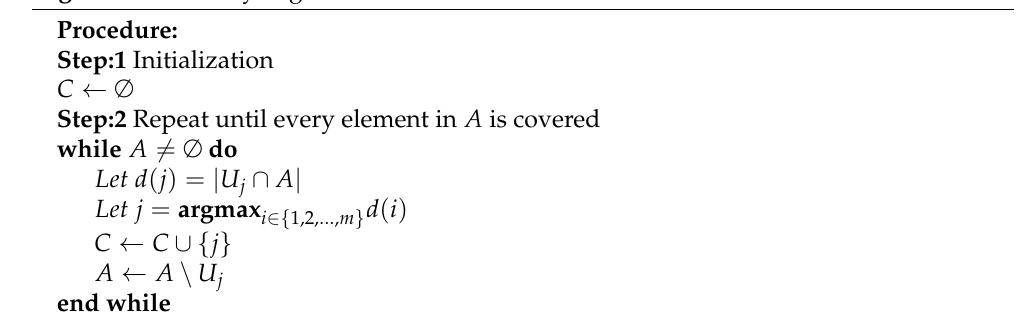
Algorithm 2 Greedy